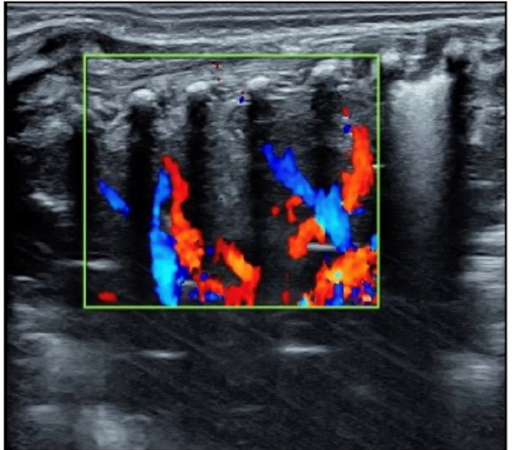
Figure 2. Blood supply in the consolidated lung area; Doppler ultrasound showed that the blood supply existed within the consolidated area. The presence of blood supply in the lung tissue of consolidation is a prerequisite for the recovery of severe atelectasis.